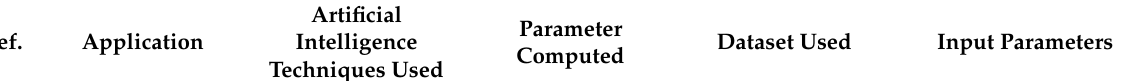
Table 2. Artificial intelligence for the estimation of soil shear